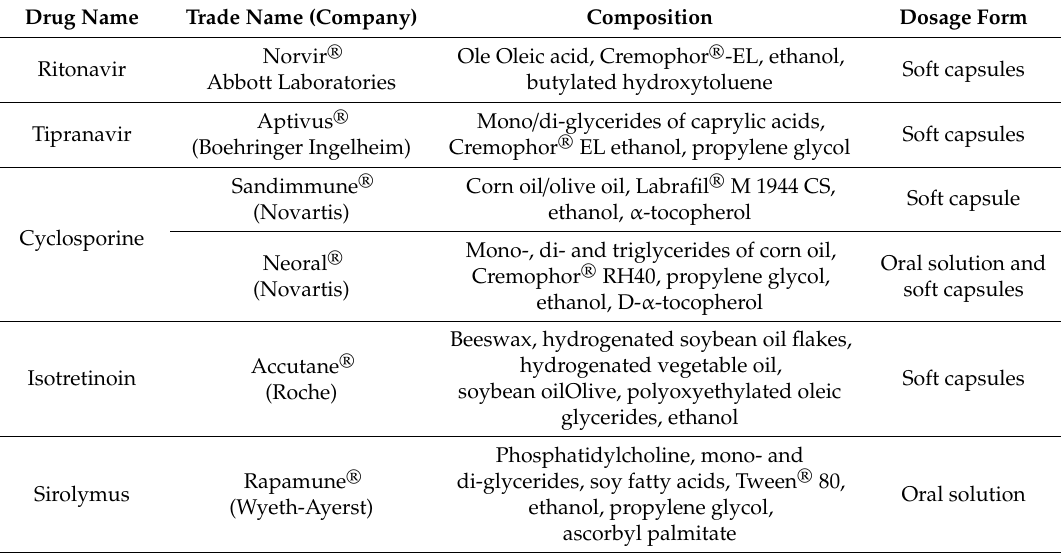
Table 5. Non-exhaustive list of marketed SNEDDSs for oral